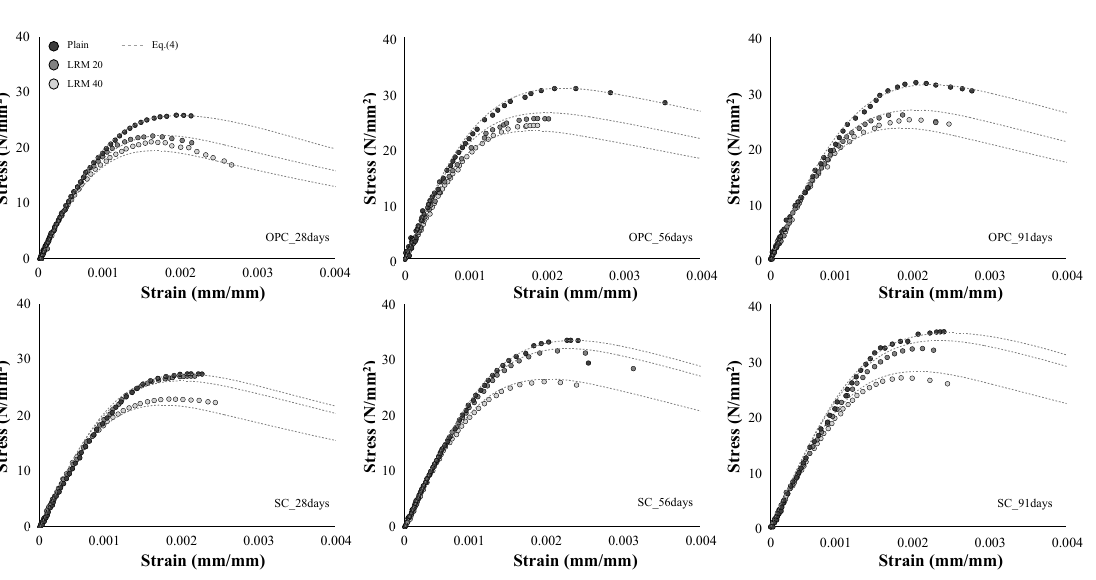
Figure 21. Approximation of the stress–strain relation curve in the case of LRM concrete.